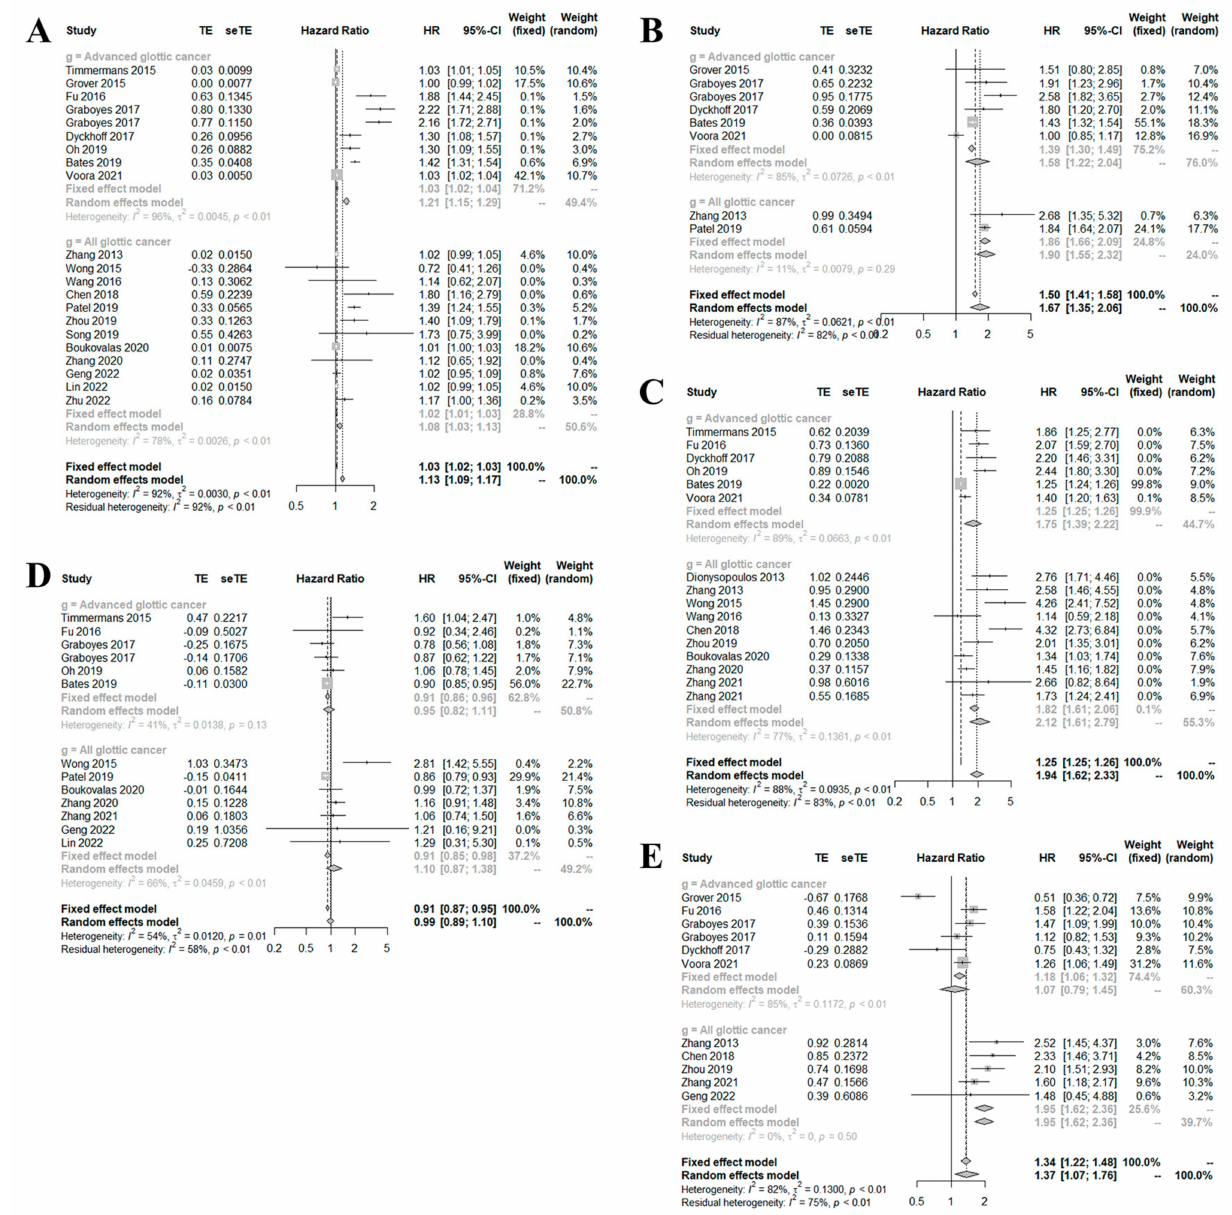
Figure 2. Forest plots of the effects of age ( A ), the Charlson comorbidity index score ( B ), nodal involvement ( C ), sex ( D ), and tumor location ( E ) on overall